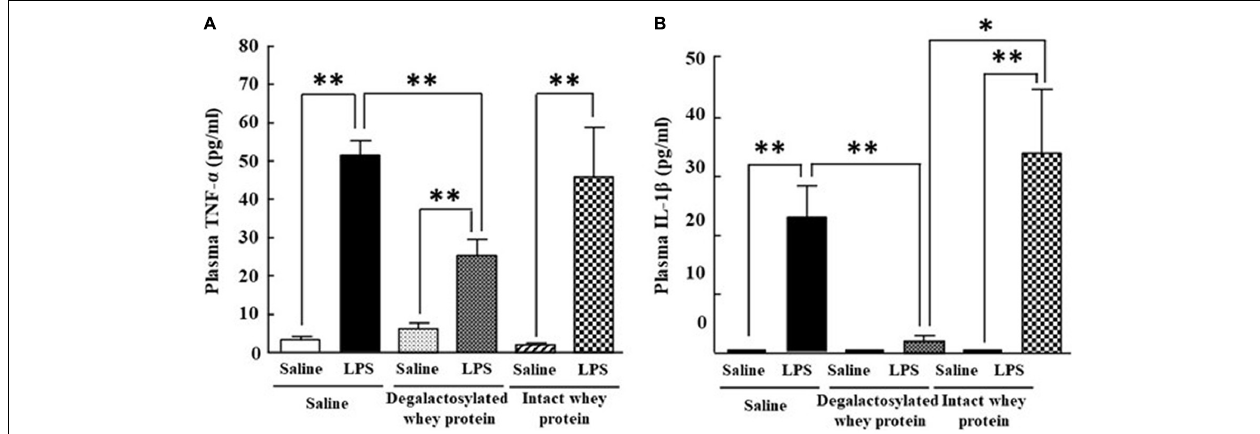
FIGURE 4 | Effects of intraperitoneal administration of degalactosylated whey protein for 5 days on increases in plasma TNF- α and IL-1 β levels induced by intraperitoneal administration of LPS in mice. (A) Changes in plasma TNF- α levels at 4 h after intraperitoneal administration of LPS (0.33 mg/kg) following intraperitoneal administration of intact and degalactosylated whey proteins (10 mg/kg) for 5 days in mice. (B) Changes in plasma IL-1 β levels at 4 h after intraperitoneal administration of LPS (0.33 mg/kg) following intraperitoneal administration of intact and degalactosylated whey proteins (10 mg/kg) for 5 days. Results are expressed as mean ± SE for 8–12 mice. ∗ p < 0.05, ∗∗ p < 0.01.